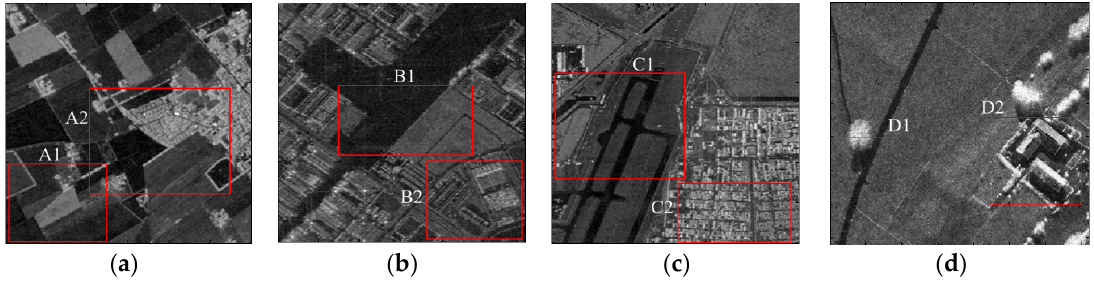
Table 1. Time (in seconds) of the three superpixel algorithms for w “ 0.6 on the simulated synthetic aperture radar (SAR) images.